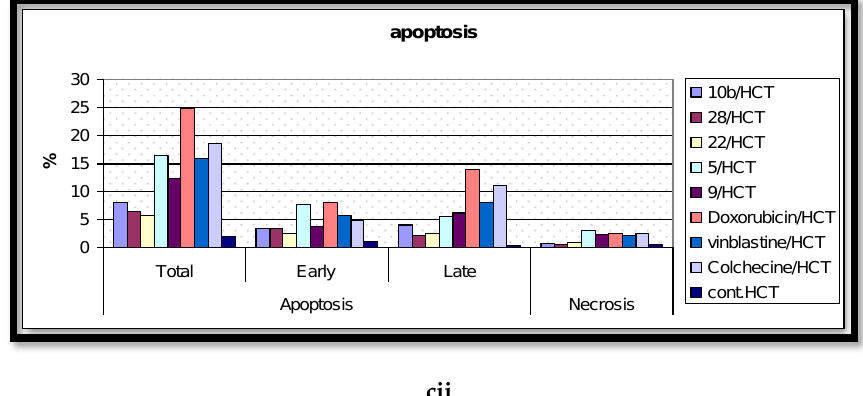
Figure 7. The effects of the DMSO, the standard anticancer drugs, and the synthesized compounds on the cell apoptosis of the ( a ) MCF-7, ( b ) HCT, and ( c ) HepG-2 cancer cell lines. ( i ) Scatter plots of Annexin-V FITC / PI cell staining. ( ii ) Histograms for the percentages of the cell apoptosis and necrosis.